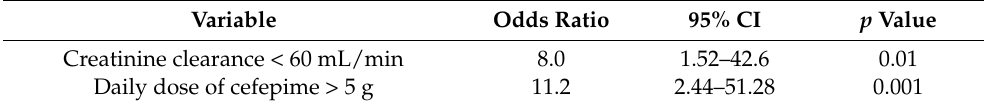
Table 2. Logistic regression analysis of independent risk factors associated with overdosing of